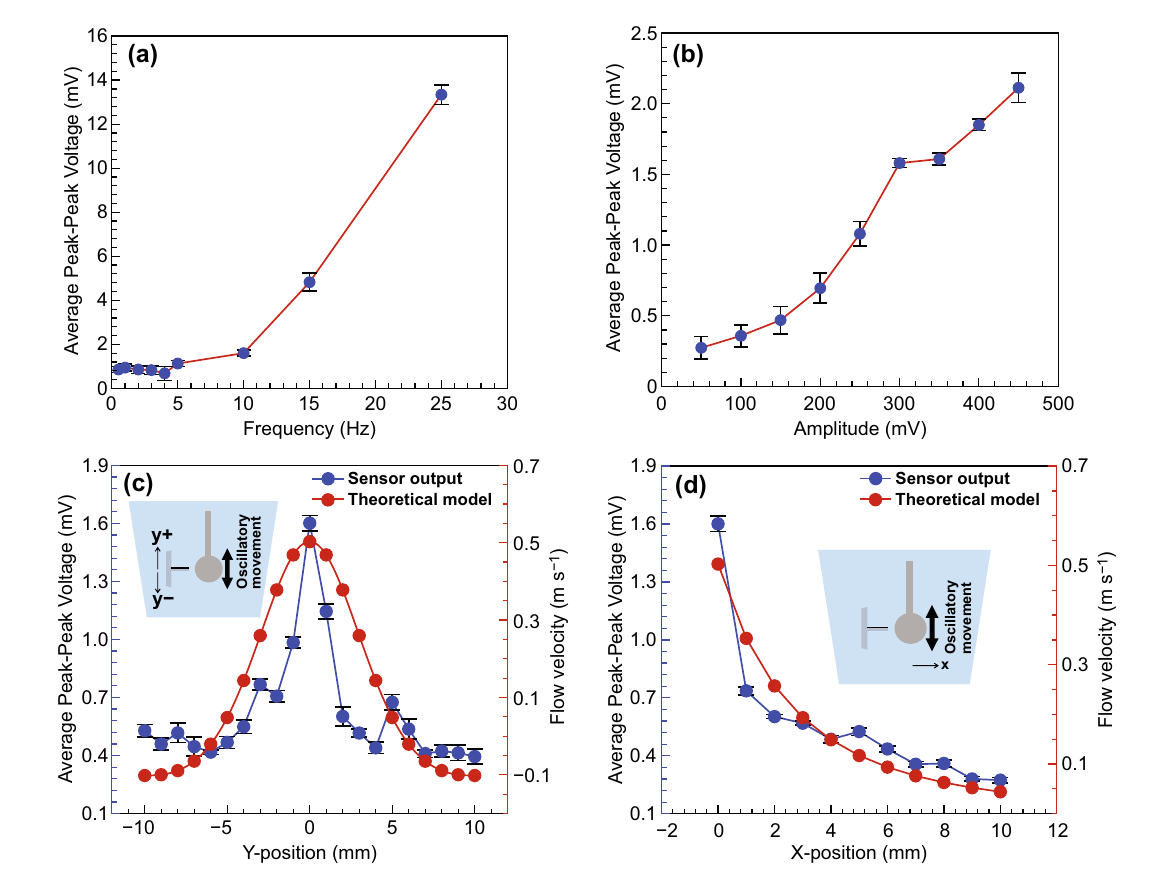
Fig. 3 a Average peak-to-peak voltage as a function of frequency for oscillatory flow characterization and object detection principles. b Aver- age peak-to-peak voltage as a function of amplitude. c Position sweep in the y -axis direction (parallel). d Position sweep in the x -axis direction